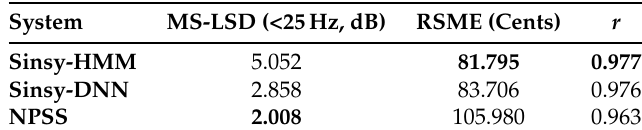
Table 3. Quantitative results of pitch models trained on natural singing. Table shows log F0 Modulation Spectrum Log Spectral Distortion (MS-LSD) in dB. The F0 Root Mean Squared Error (RMSE) in cents and Pearson correlation coefficient r are also given for reference. The IS16 and HTS systems are excluded from this comparison because they are not suitable for modeling F0 from natural singing.